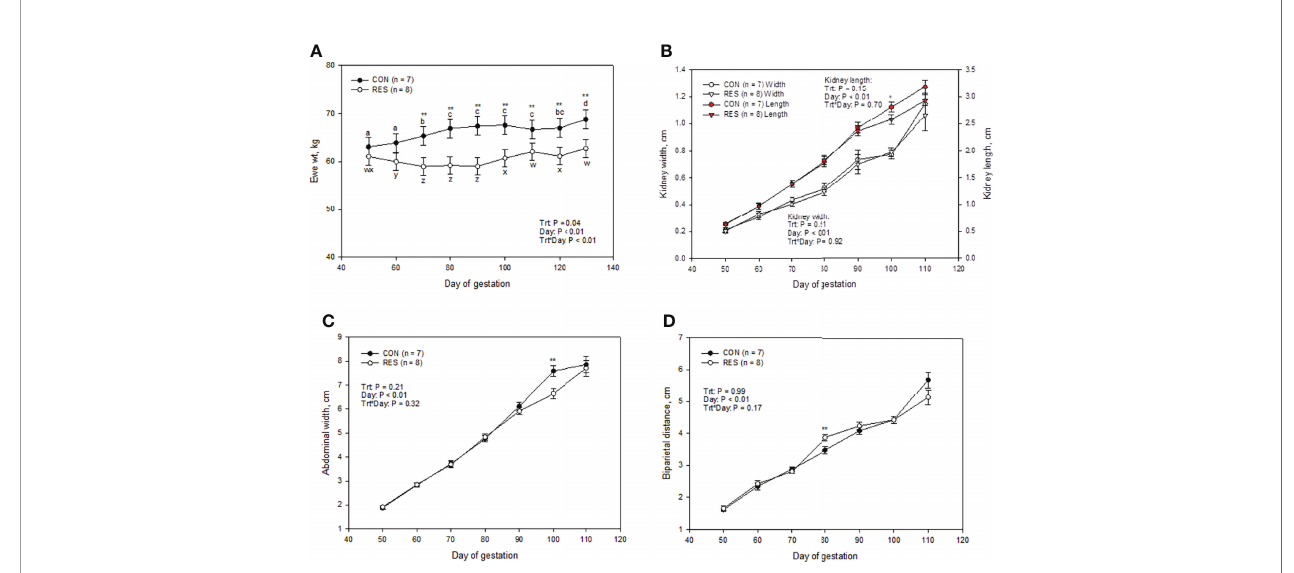
FIGURE 1 | Impacts of maternal nutrition on ewe weight (A) , fetal kidney length and width (B) , abdominal width (C) , and biparietal distance (D) from d 50 to 110 of gestation. CON = 100% of NRC recommendations. RES = 60% of CON from day 50 to 90 of gestation. abcd LSMEANS ± SEM between day differ P ≤ 0.05. Differences between CON and RES are denoted by **P ≤ 0.05, *P ≤ 0.10 within a